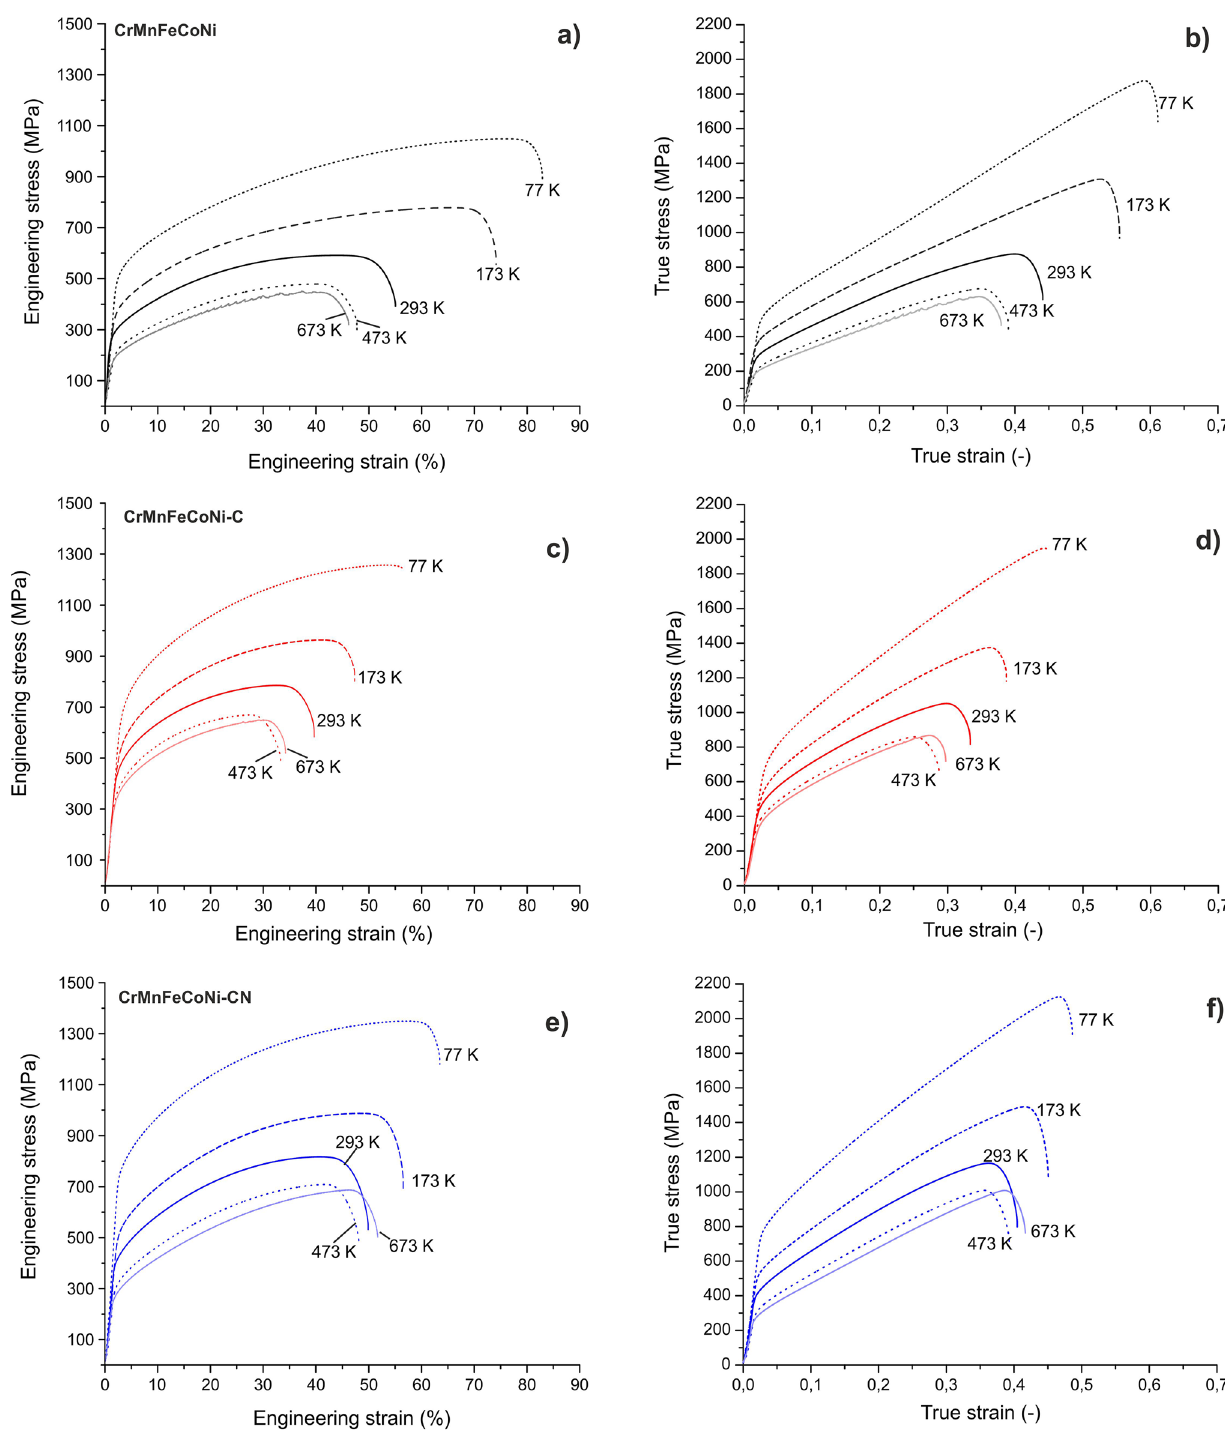
Fig. 3 Engineering and true stress-strain curves of the high-entropy